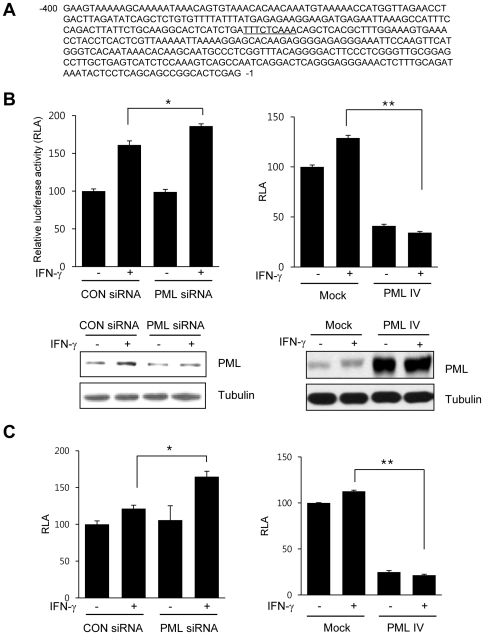
PML Expression Represses IFN-γ-inducible IP-10 Promoter Activity.(A) The murine IP-10 promoter contains a putative GAS-like element (underlined). (B) NIH3T3 cells were co-transfected with the IP-10-luc reporter containing a GAS-like element and/or Pml siRNA, or the PML IV protein expression vector. Cells were either untreated or treated with murine IFN-γ (10 ng/ml) for 24 h, and then luciferase activity was determined. The pCMV-β-galactosidase vector was included to normalize transfection efficiency. Luciferase activity is normalized to the activity in the absence of IFN-γ and the activity from parental cells was arbitrarily set at 100% (RLA; relative luciferase activity). Increased or reduced PML protein expression in cell lysates transfected with either PML IV expression vector or Pml siRNA was verified by immunoblotting, respectively. (C) SNU-638 gastric cancer cells were co-transfected with the IP-10-luc reporter containing a GAS-like element and/or Pml siRNA, or the PML IV protein expression vector and analyzed as described in B. Values are the mean ± SD of three separate experiments. Bars, SD. *P<0.05, **P<0.001.